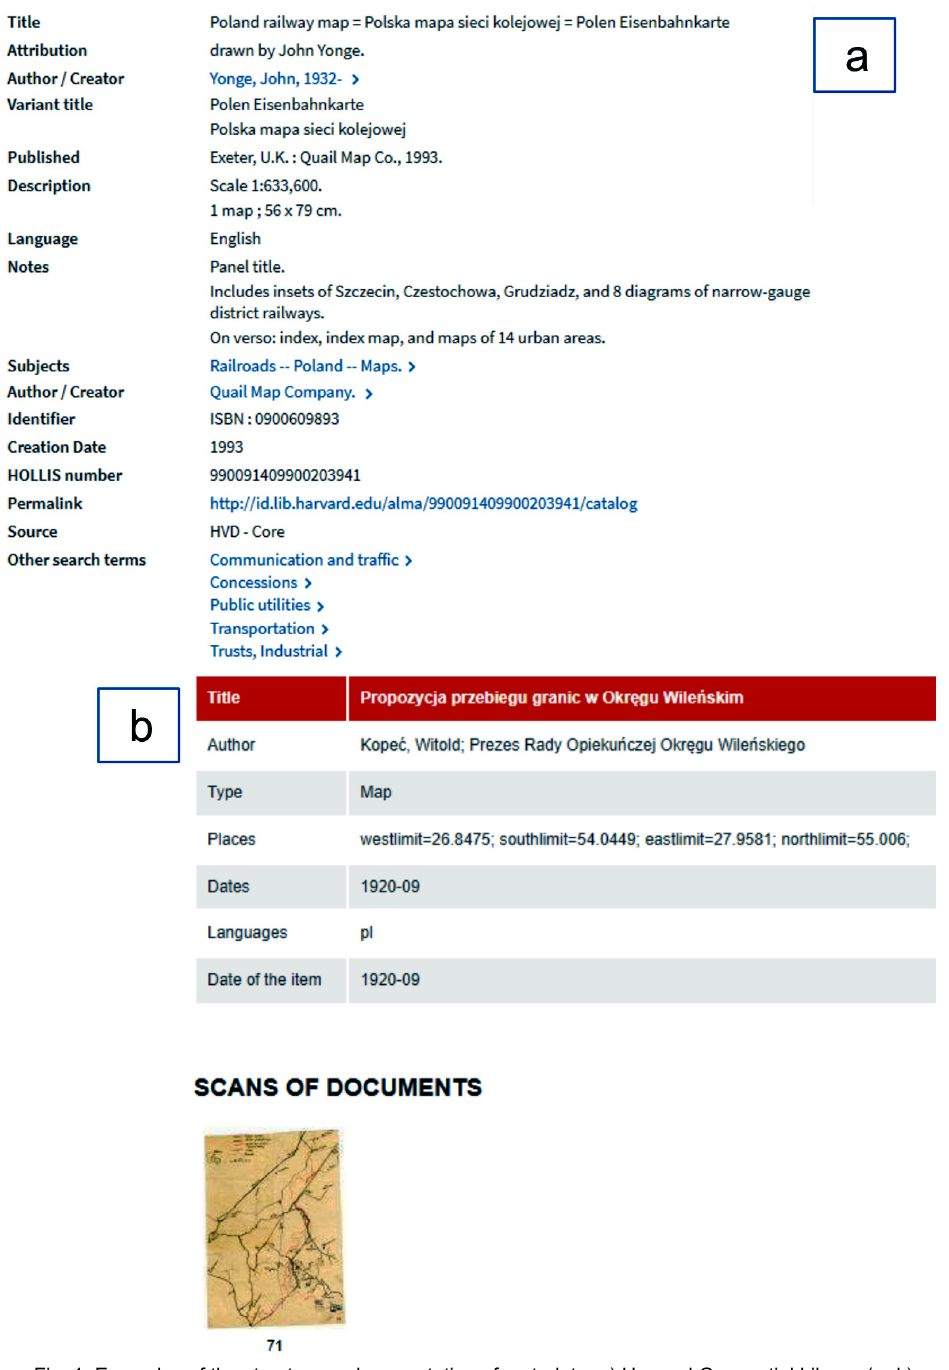
Fig. 1. Examples of the structure and presentation of metadata: a) Harvard Geospatial Library (n.d.); b) the repository of the Józef Piłsudski Institute in America (n.d.) (author’s